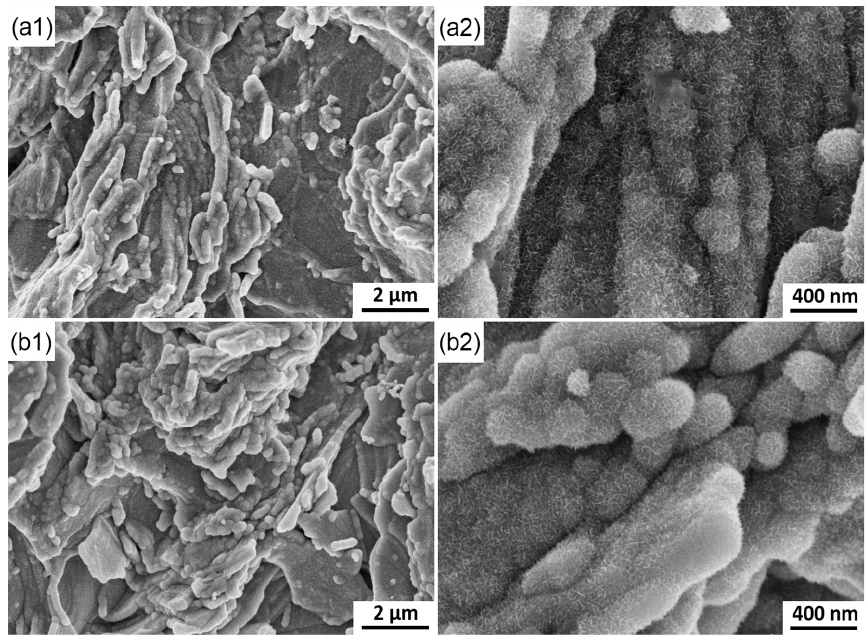
Figure 10. SEM images of the electrode surface at different deposition time. ( a ) 8 s; ( b ) 9